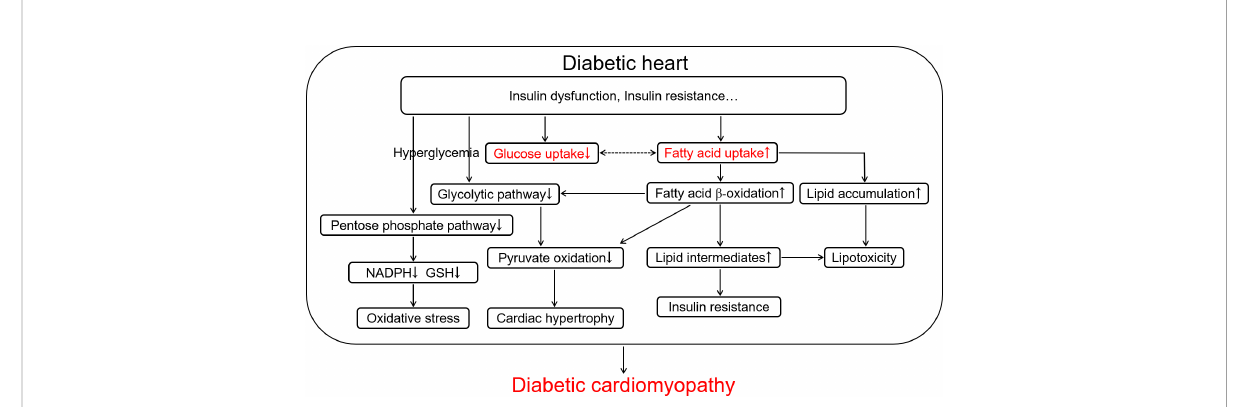
FIGURE 1 The scheme of glucose and lipid metabolism disorder in the diabetic heart contributing to diabetic cardiomyopathy. Diabetes-induced insulin dysfunction and insulin resistance cause the increase in fatty acid uptake characterized by up-regulation of fatty acid b -oxidation and lipid accumulation and the decrease in glucose uptake accompanying with hyperglycemia and down-regulation of pentose phosphate pathway and glycolytic pathway in the cardiomyocyte. Up-regulation of fatty acid b -oxidation further promotes the inhibition of glycolytic pathway and pyruvate oxidation, and increases lipid intermediates and lipotoxicity. These metabolic alterations in diabetes ultimately cause oxidative stress, further insulin resistance, and cardiac hypertrophy, which aggravates the development of diabetic cardiomyopathy. NADPH, reduced form of nicotinamide adenine dinucleotide phosphate; GSH, reduced